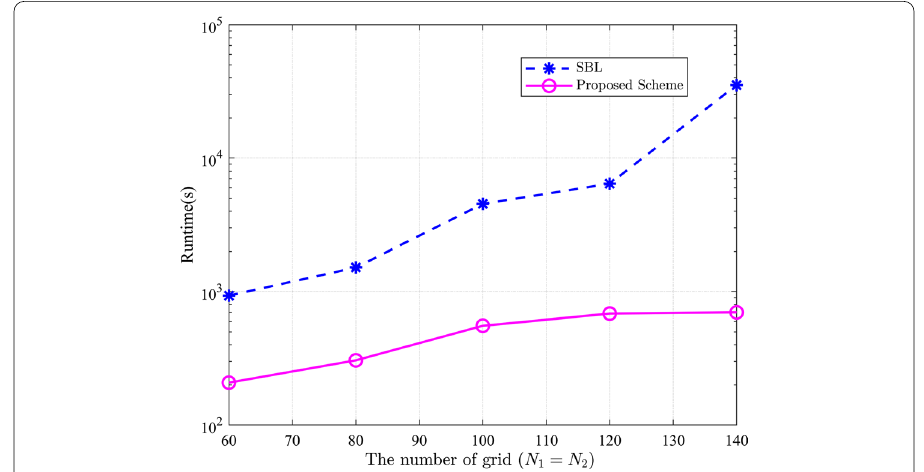
Fig. 7 Running time against the number of grids when N y = 32 , N t = N r = 64 are considered, respectively